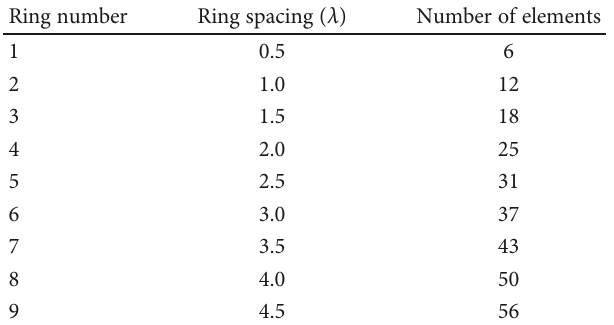
Table 1: Ring spacing and numbers of elements for case